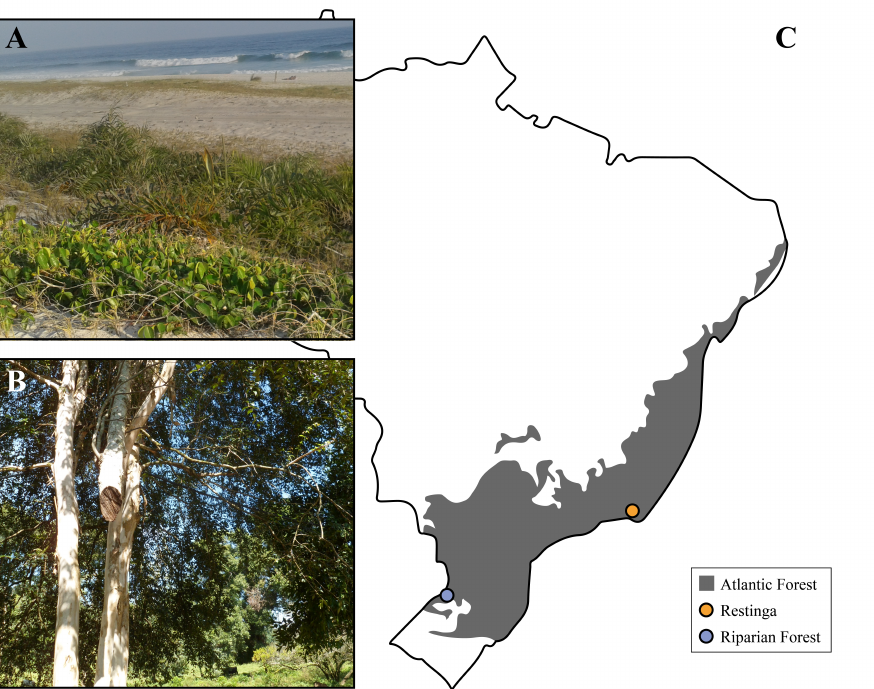
Figure 1. Eugenia uniflora individuals along the Atlantic Forest. ( A ) Restinga. ( B ) Riparian Forest. ( C ) Atlantic Forest dispersion along the Brazilian coast. Sampling points are depicted by colored dots. DNA-binding with one finger ( DOF ) proteins are part of a transcription factor (TF)